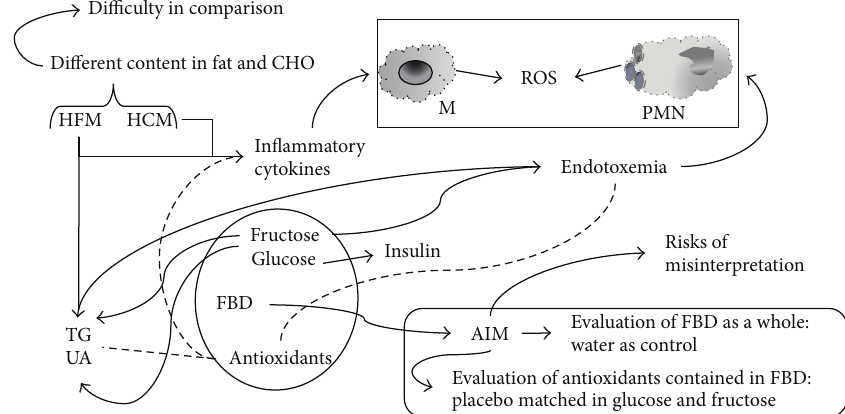
Figure 1: Difficulty in comparison of postprandial studies and risk of misinterpretation due to control choice. CHO: carbohydrates; FBD: fruit-based drink; HCM: high carbohydrates meal; HFM: high fat meal; M: monocytes, PMN: polymorphonuclear cells; ROS: reactive oxygen species; TG: triglycerides; UA: uric